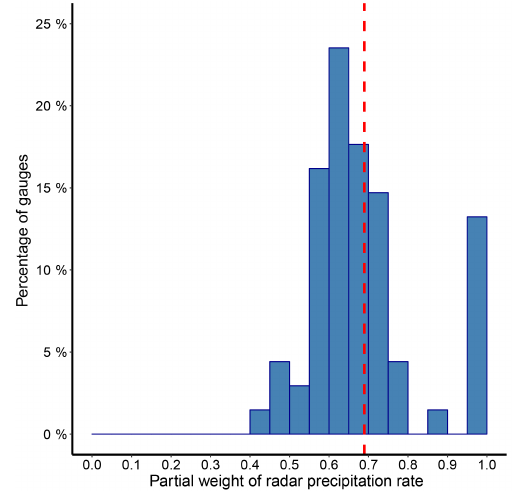
Figure 2. The percentage of precipitation gauge locations against estimated partial weight of the radar precipitation rate ( β R ) at those gauge locations and the mean partial weight (red dash line) for gauge locations (68 gauges) in the study area. Partial weights pro- vide a measure of relative importance of predictor variables on the response (refer to Eq. 3), and the summation of partial weights ( β R + β T ) is equal to